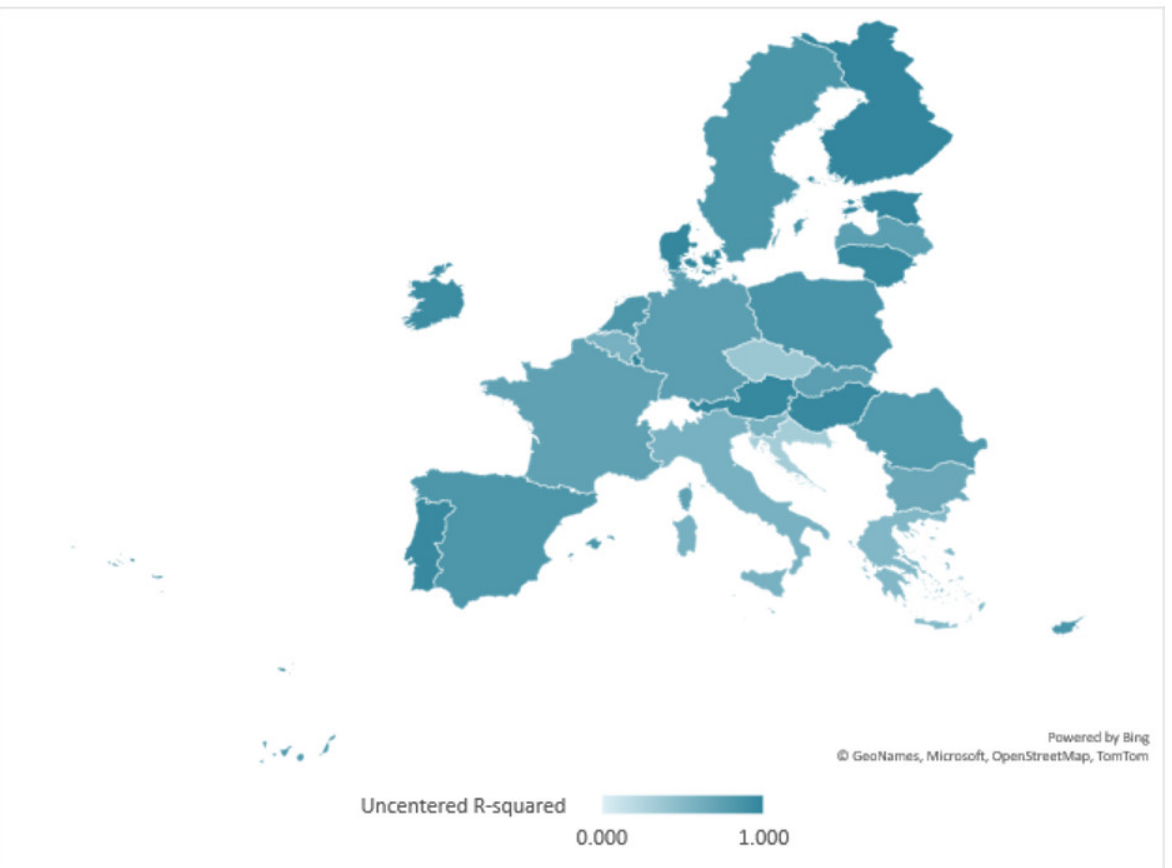
Figure 2. Geospatial distribution of the statistical significance of combined policies to reduce heavy metal pollution in water.